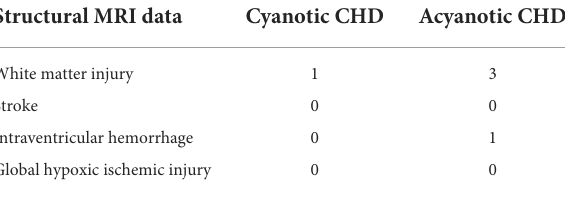
TABLE 6 Structural MRI of CHD neonates. Structural MRI data Cyanotic